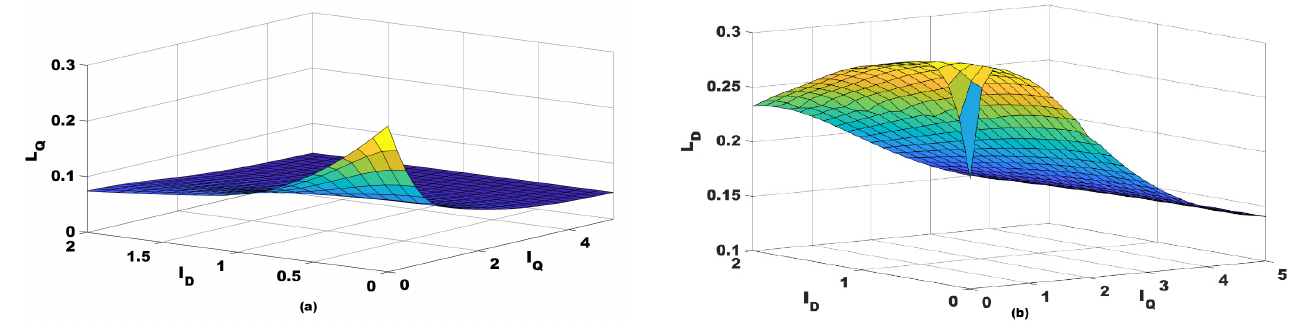
Figure 4. Variation of ( a ) L q and ( b ) L d values for variation in currents.